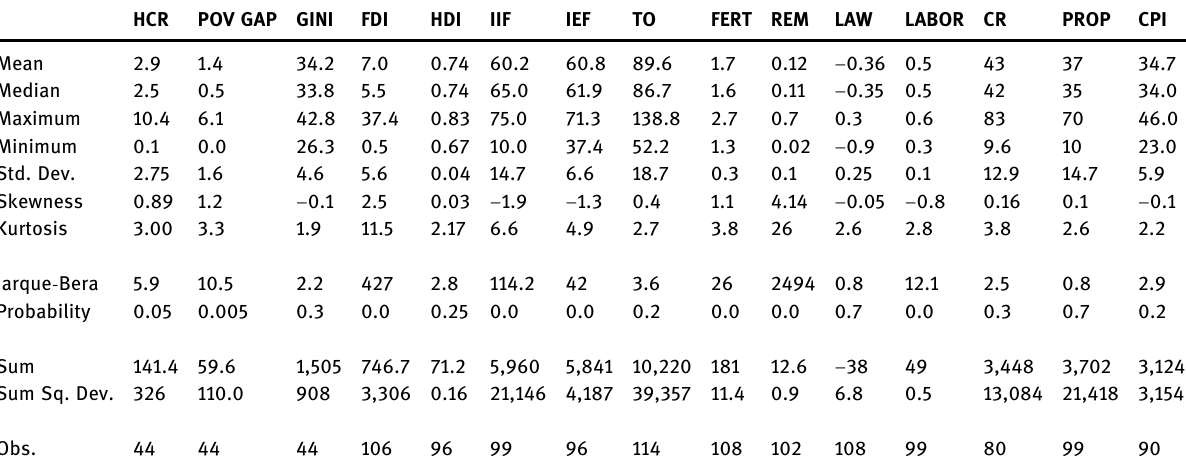
Table A2: Summary of descriptive statistics for Western Balkans, 2002 – 2021